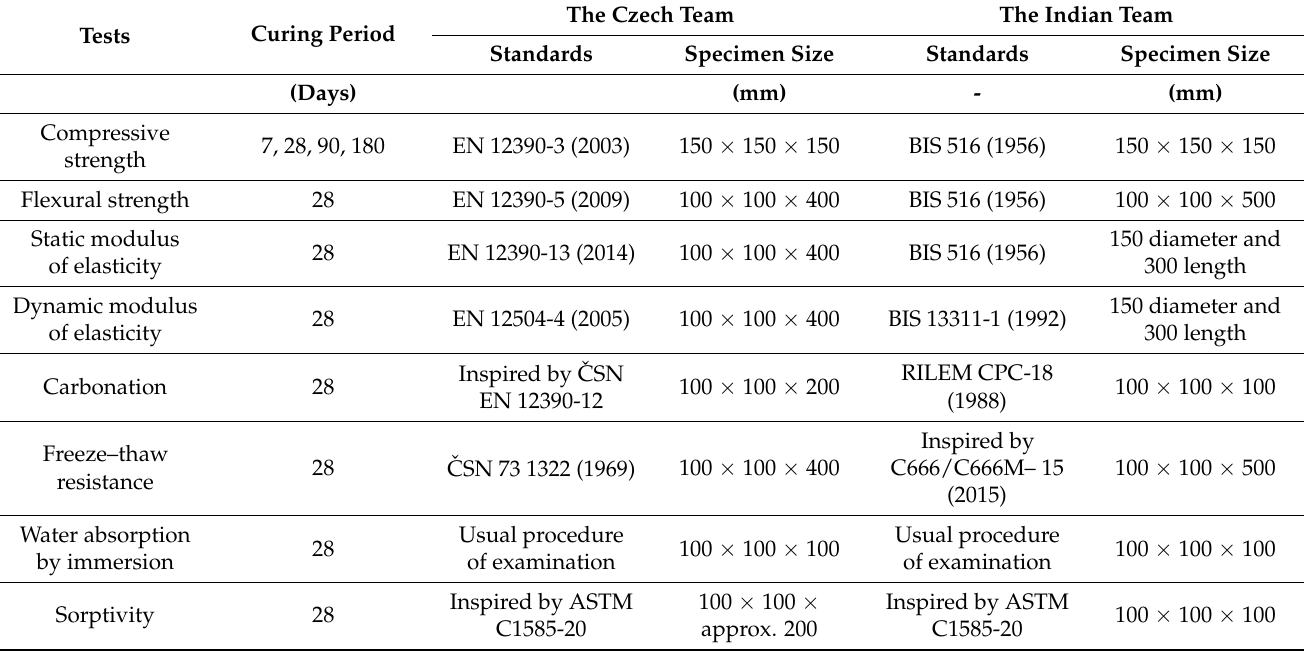
Table 4. The overview of test methods for concrete